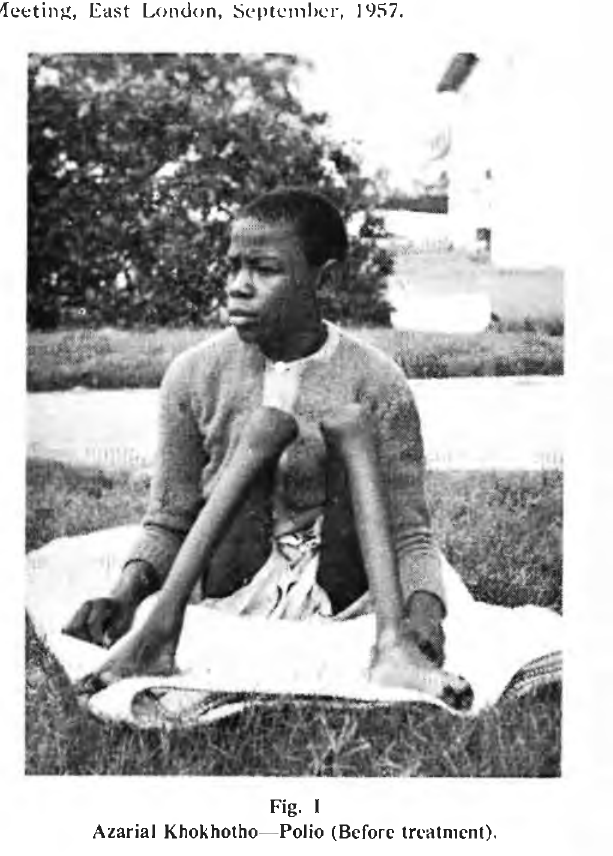
Fig. I Azarial Khokhotho—Polio (Before